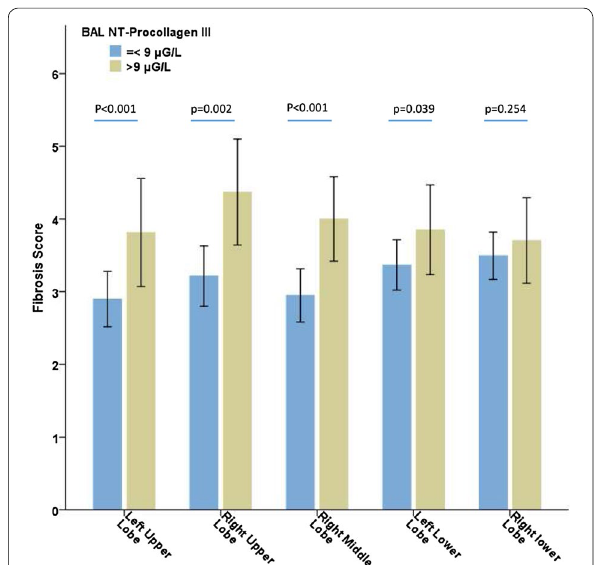
Fig. 3 CT scan fibrosis score according to lung segmentation. Error bars represent standard error of mean (SEM), BAL bronchoalveolar lavage, NT-PCP-III N‑terminal peptide for type III procollagen